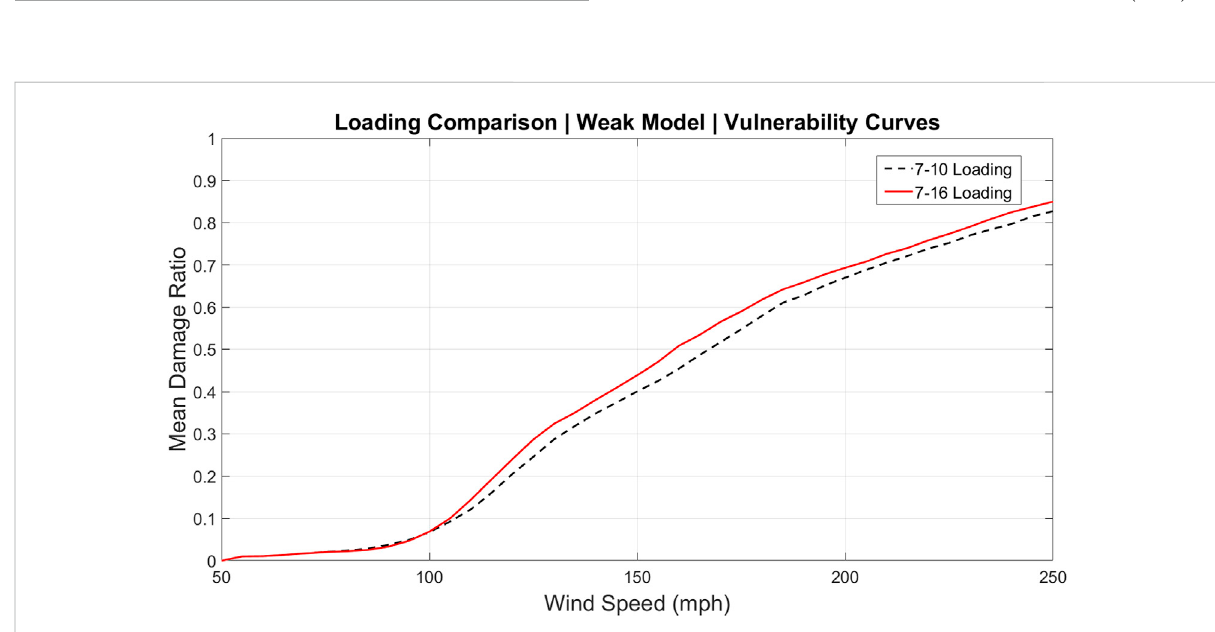
FIGURE 3 Vulnerability curves of the weak model using ASCE 7 – 10 and ASCE 7 – 16